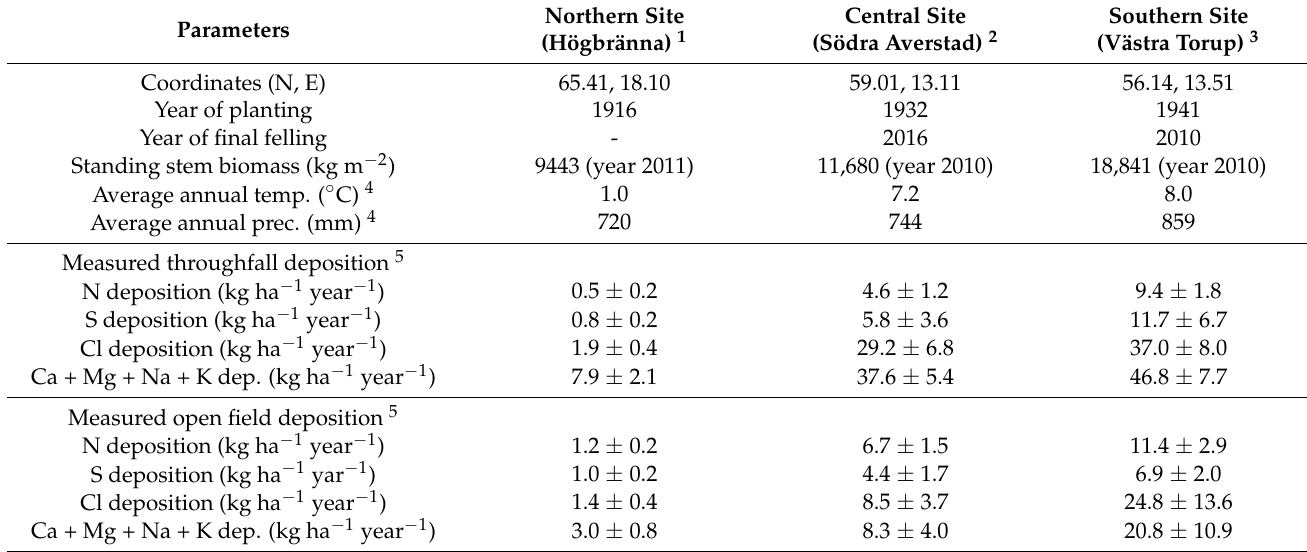
Table 2. Description of the three modeled